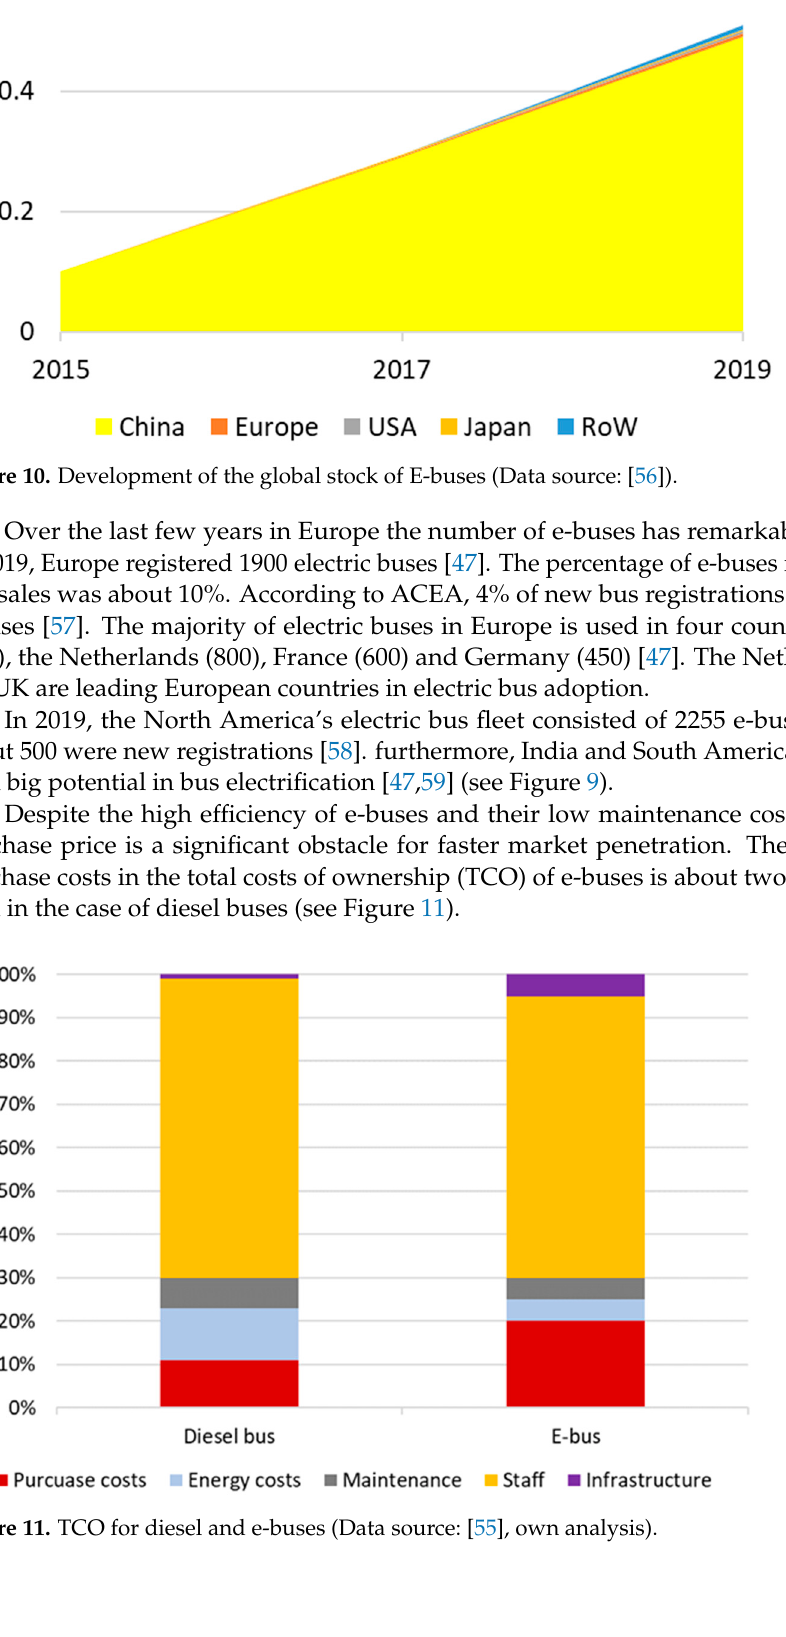
Figure 9. New e-bus registrations by country/region, 2015–2019 (Data source: [47]).